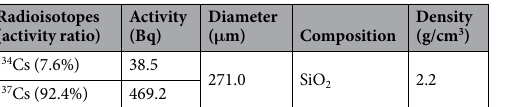
Table 1. Properties of a Type B particle incorporated into the PHITS. The activities for 134 Cs and 137 Cs were deduced as of March 11, 2011. The shape of the Type B particle is assumed as sphere for simplicity and the diameter is given by the measurement with the Image J software analysis. The composition of the particle was assumed to be SiO 2 in 2.2 g/cm 3